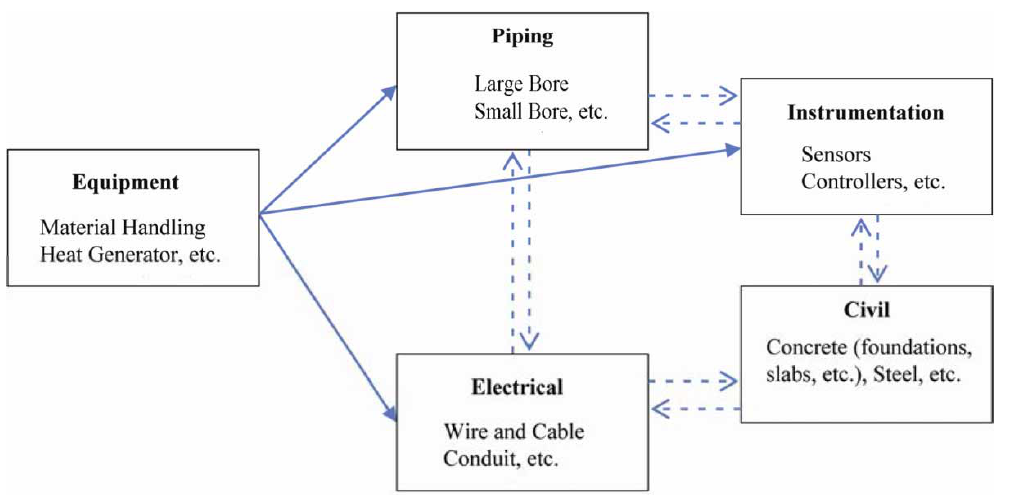
Fig. 2. Information exchange patterns among various engineering